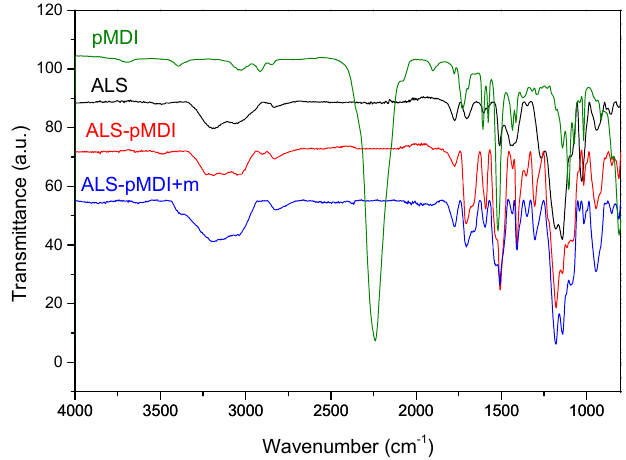
Figure 5. Fourier transform infrared spectroscopy (FTIR) spectra of pure pMDI and cured adhesive formulations with ALS, ALS-pMDI, and ALS-pMDI + m.